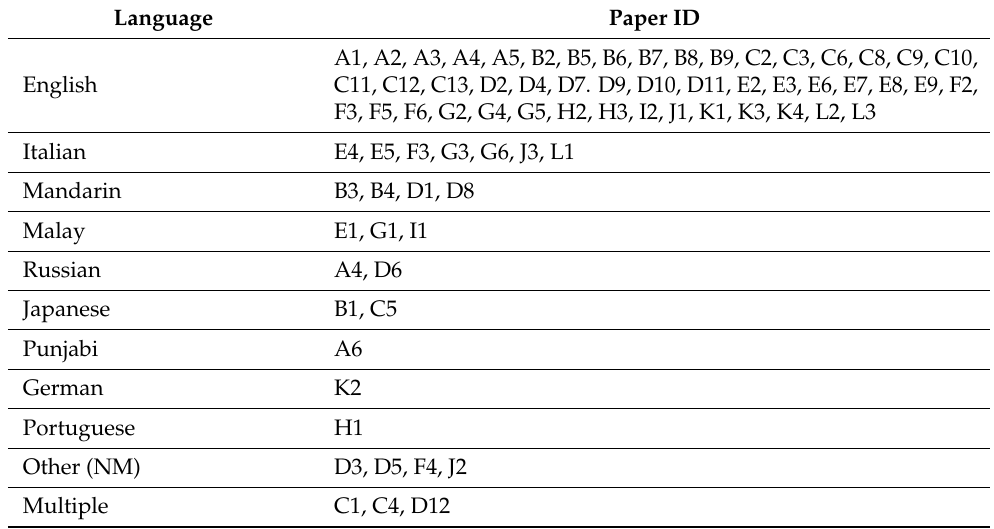
Table A3. Natural languages used in the